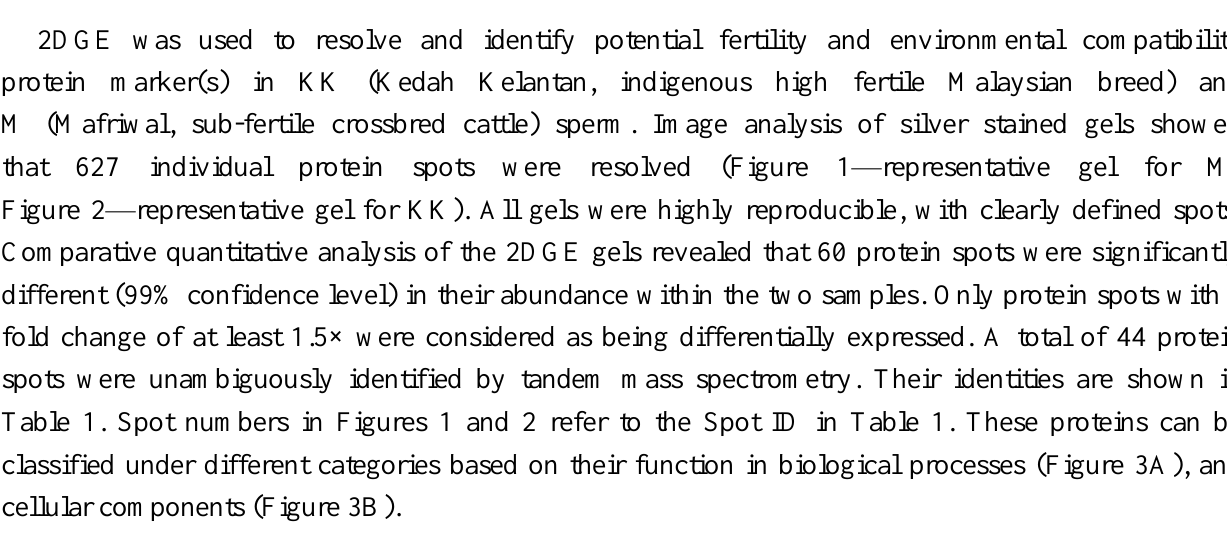
Figure 1. Representative gel showing protein spots with different abundance in Mafriwal